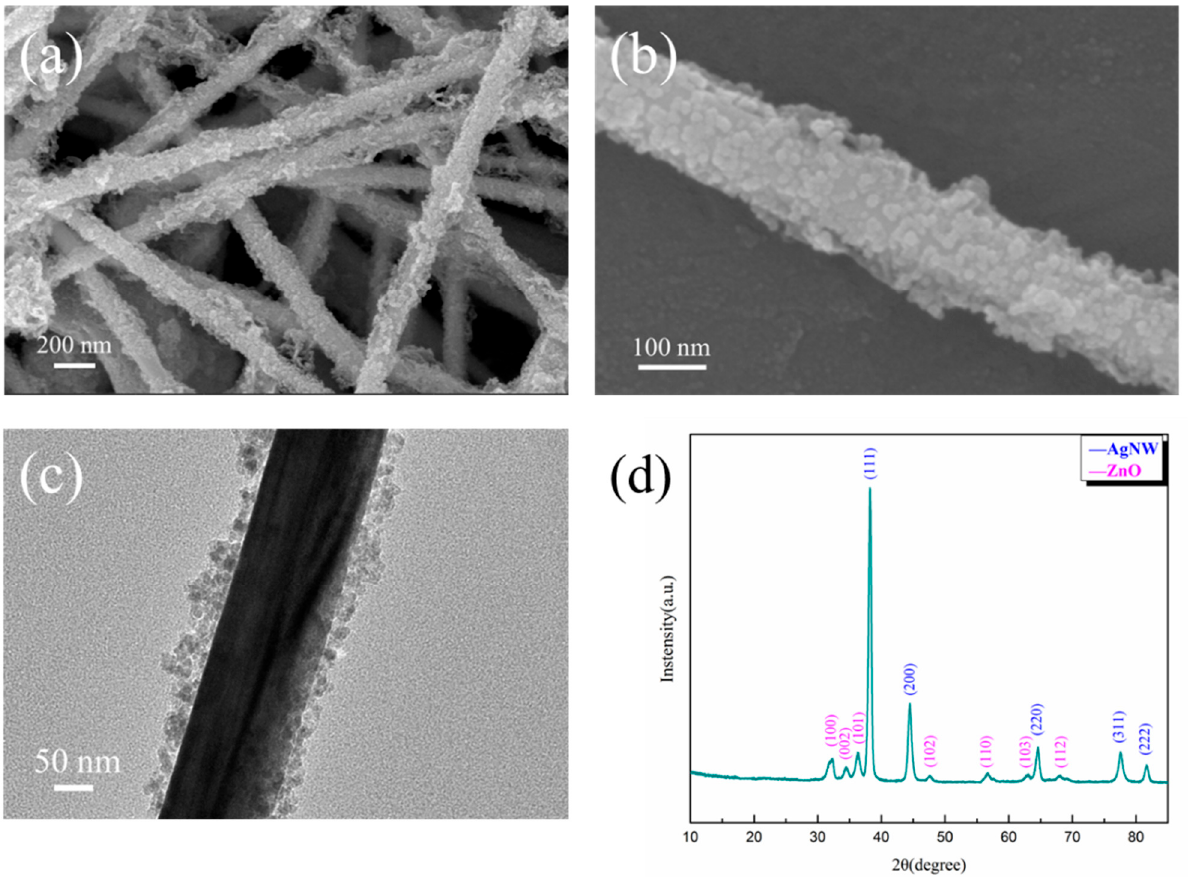
Figure 4. ( a , b ) are SEM images of the prepared AgNW@ZnO; ( c ) TEM image of AgNW@ZnO; ( d ) XRD pattern of AgNW@ZnO.